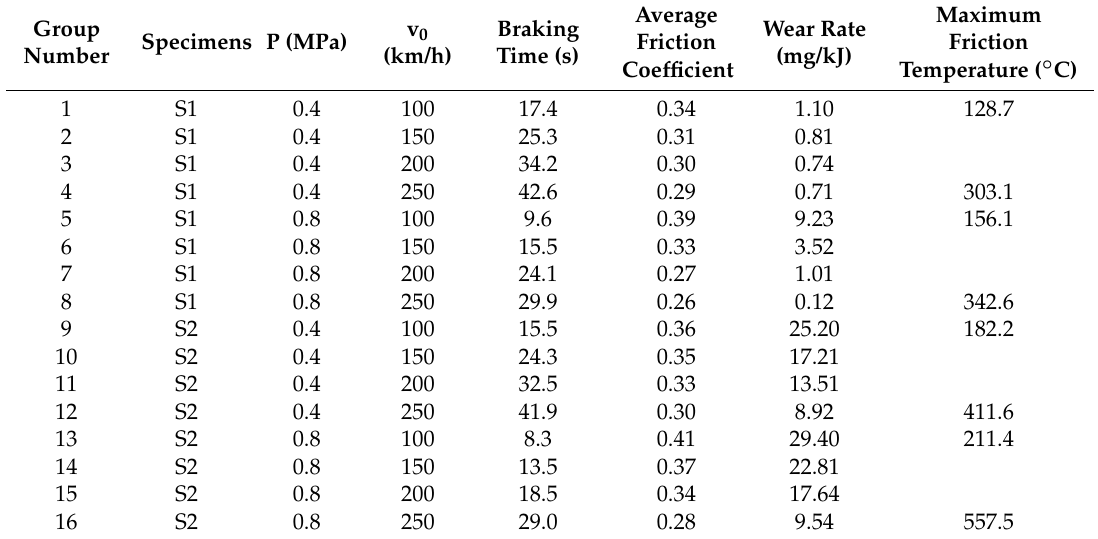
Figure 3. Schematic of test bench structure ( a ) and friction pair ( b ). Table 2. Test groups and results of friction and wear test.